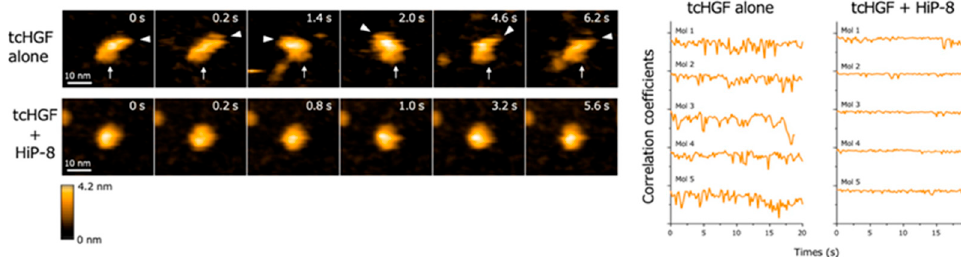
Figure 4. Flexible and dynamic domain movement in tcHGF, and the inhibition of the molecular dynamics of tcHGF by HiP-8 [20]. The left panels show the real-time changes in the molecular shape of tcHGF with or without HiP-8. The lines in the right panels indicate quantitative time-dependent changes in the molecular shape of individual tcHGF molecules. The remarkably changing curves in tcHGF indicate flexible and dynamic changes in molecular shape, while such dynamic changes of tcHGF are inhibited by HiP-8, indicating a change from a dynamic to a static state in tcHGF by HiP- 8.